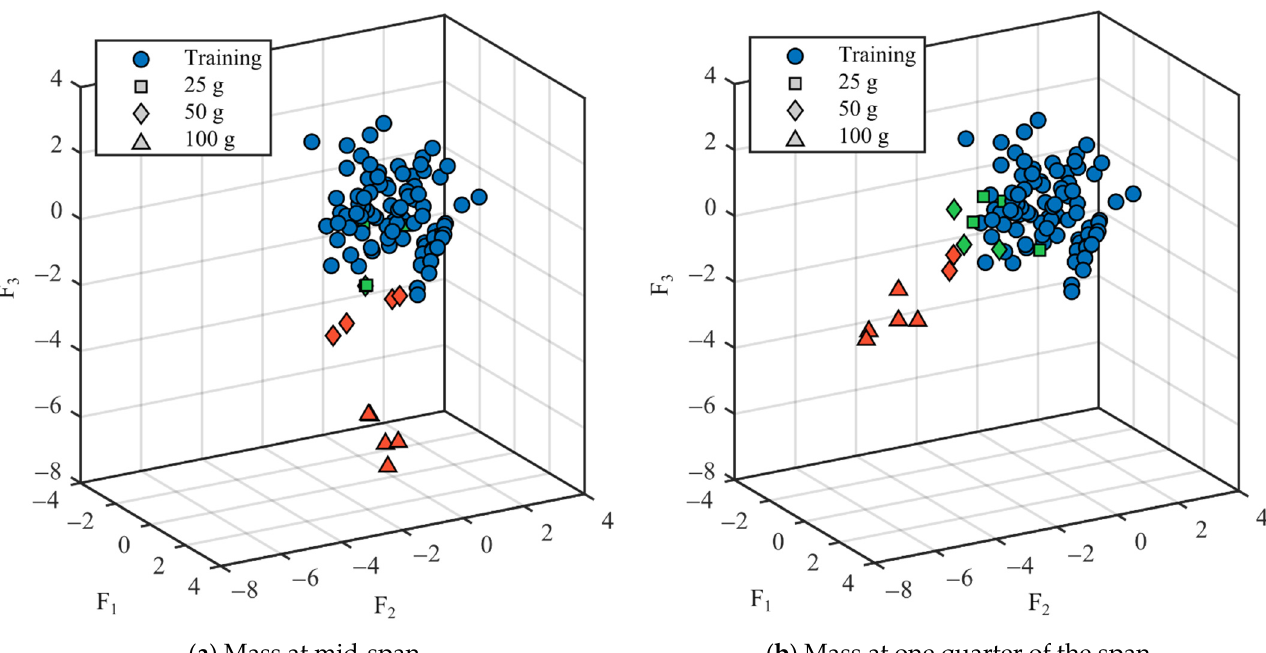
Figure 12. Standardized natural frequencies. The training database is represented with blue circles. The points corresponding to the three levels of damage are plotted in green if they were classified as ‘undamaged’ and in red if they were classified as ‘damaged’.